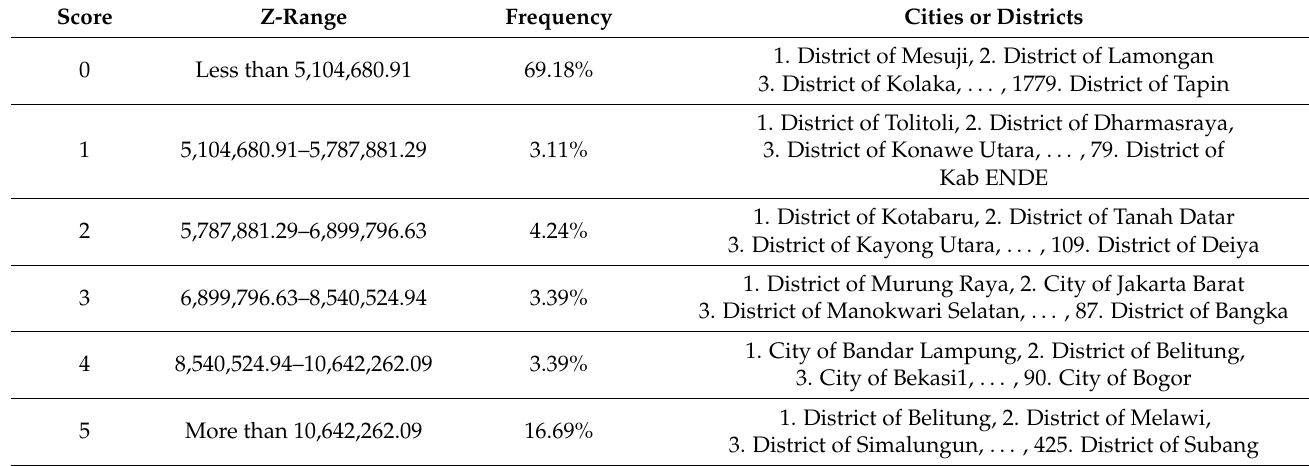
Table 2. Frequency distribution of economic resilience scores for all Indonesian